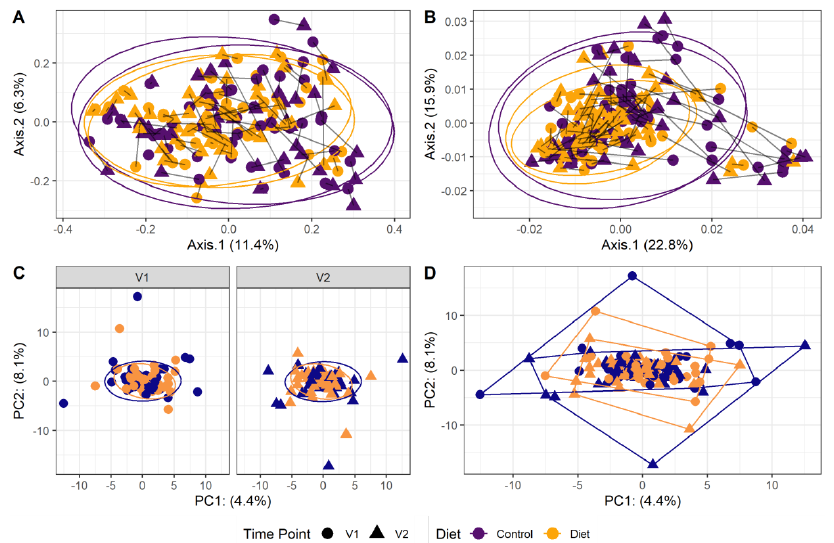
Figure 4. Microbiota beta diversity was not affected by increasing protein intake. ( A , B ): Principle coordinate analysis (PCoA) based on Bray – Curtis dissimilarity ( A ) and weighted UniFrac ( B ) measures. These are measures used to evaluate overall microbial compositional differences between groups. Each point indicates one sample from one participant (yellow: diet group, purple: control group, dot: baseline visit (V1), triangle: 6 month follow-up visit (V2)). Points from one participant are linked. The closer the points are mapped together, the more the microbial composition is alike.